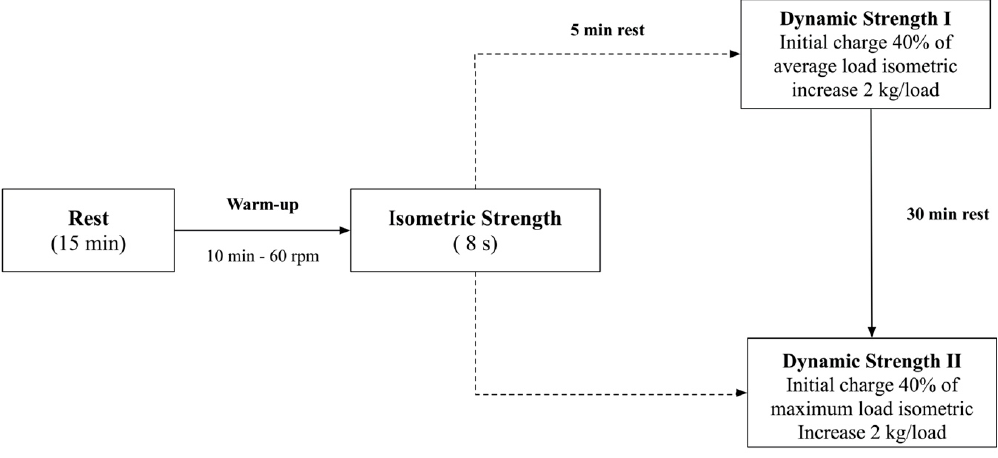
Figure 2. Scheme of protocols to assess isometric and dynamic strength.